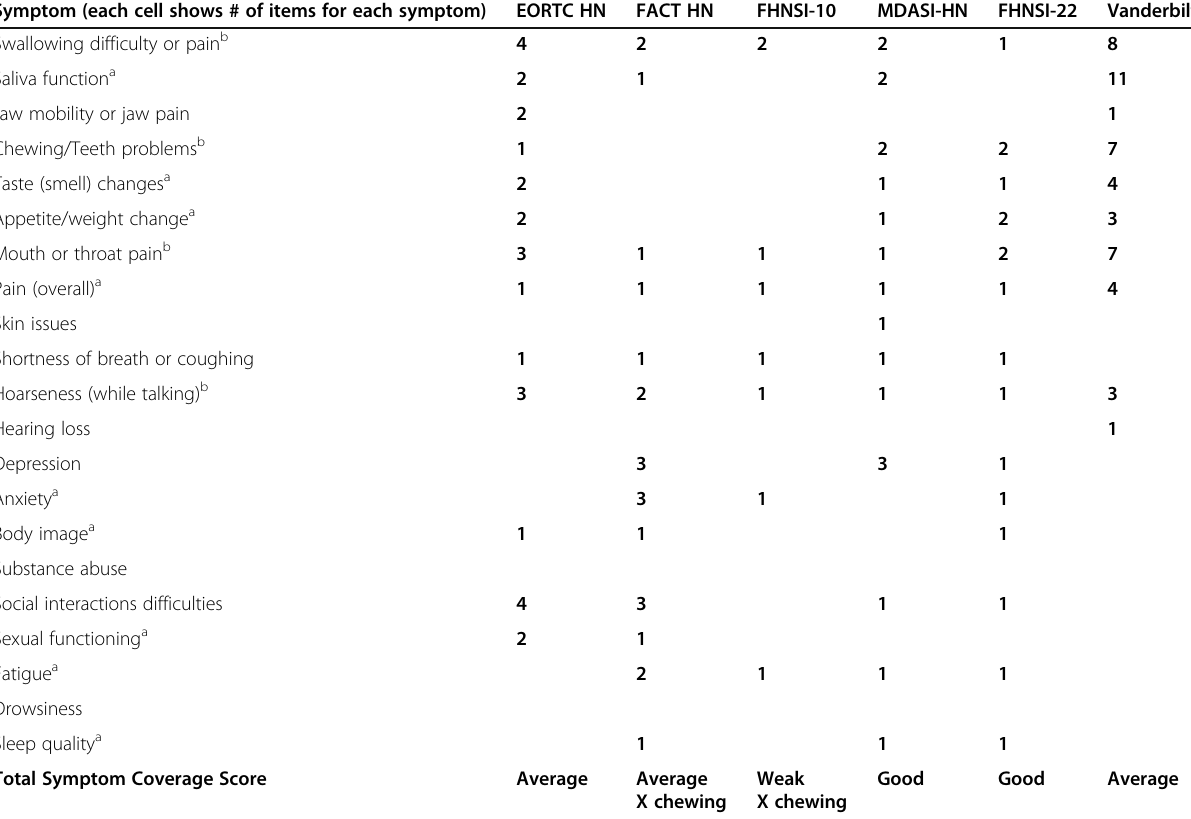
Table 2 PROM selection process symptom coverage category – head and neck test case Symptom (each cell shows # of items for each